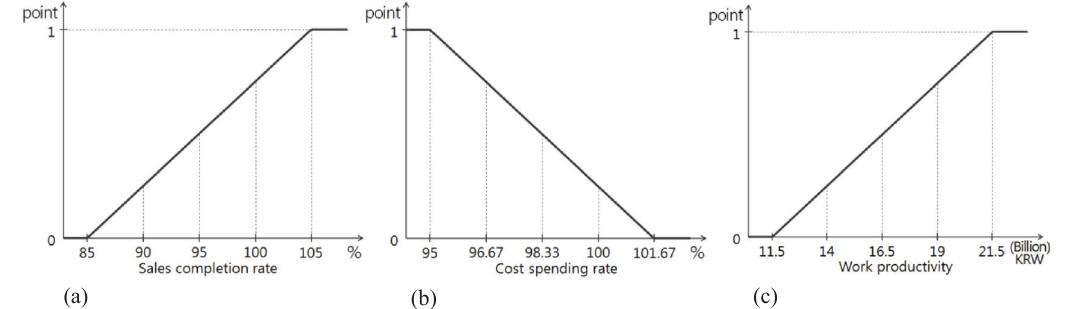
Fig. 3. Utility function for normalizing three sub-indicators: (a) the sales completion rate, (b) the cost spending rate, and (c) the work